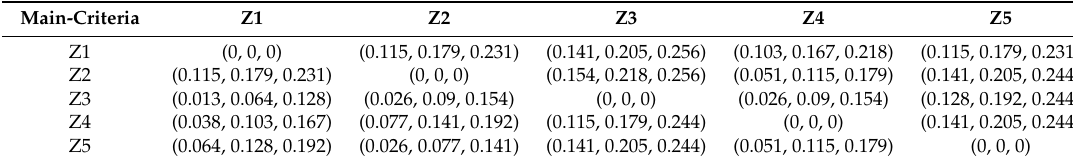
Table 9. The normalized direct relation matrix of the main criteria.